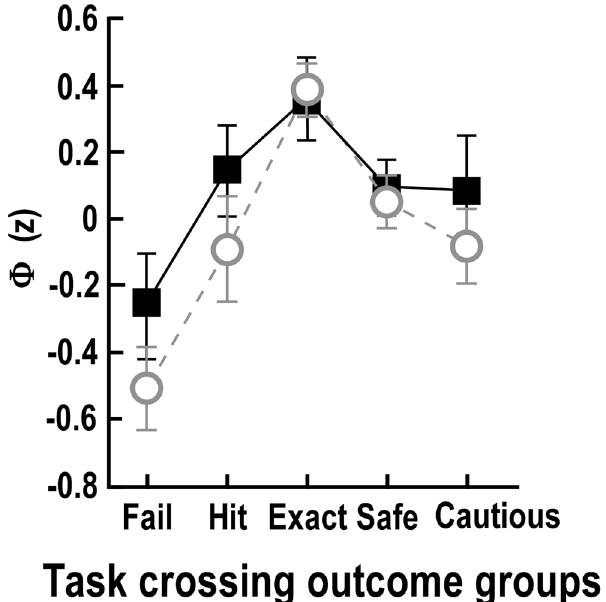
Fig 7. Everyday risk-taking scale scores by crossing outcome group. A. Scores on the Everyday risk- taking scale are plotted as filled squares for the five task-crossing outcome groups. A more positive score reflects more daring behaviour. Open grey circles show averaged normalised performances on tests of physical and cognitive function (reproduced from Fig 6X). A more positive score reflects better function. Scores are presented as means (z units ±